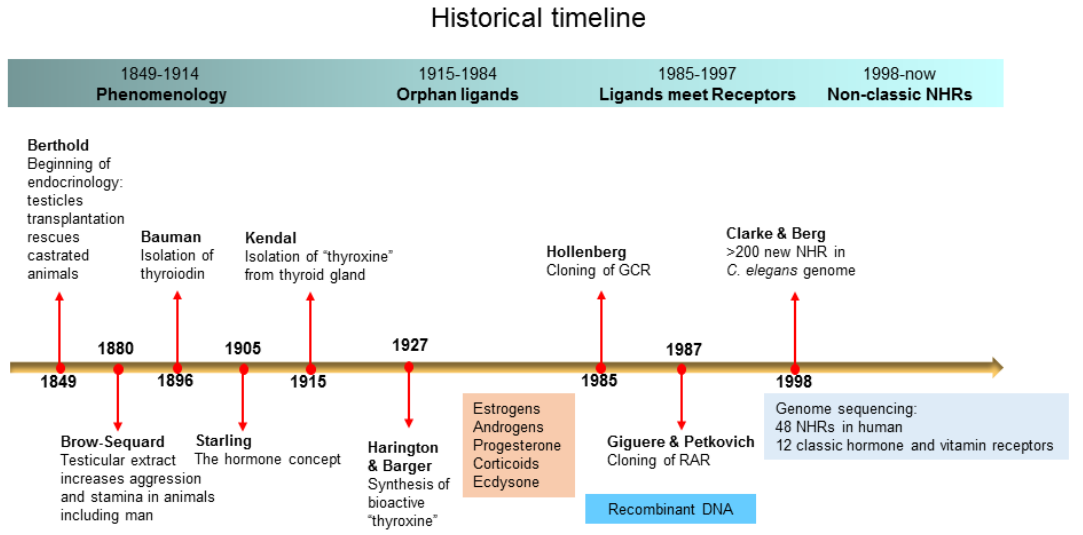
Figure 1. A brief history of nuclear hormone receptors (NHRs). Shown are the landmark moments in the history of NHRs.